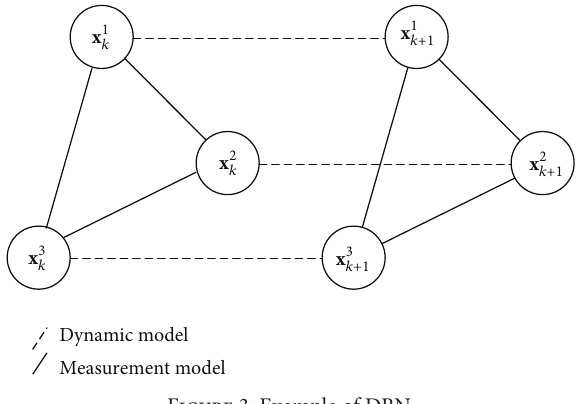
Figure 3: Example of